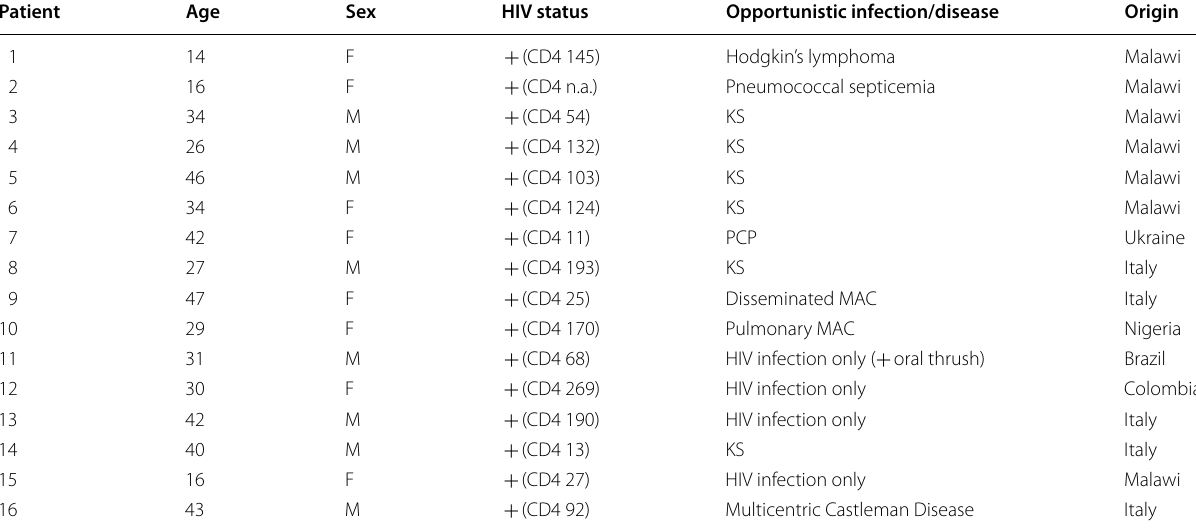
Table 1 Characteristics of patients identified with reticulo-nodular “sponge pattern” of the spleen Patient Age Sex HIV status Opportunistic infection/disease